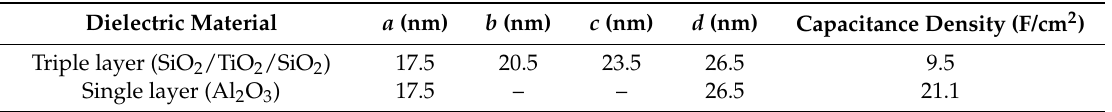
Table 5. Distances from the pore axis to the different dielectric layers and estimation of the capacitance density for the manufactured devices.